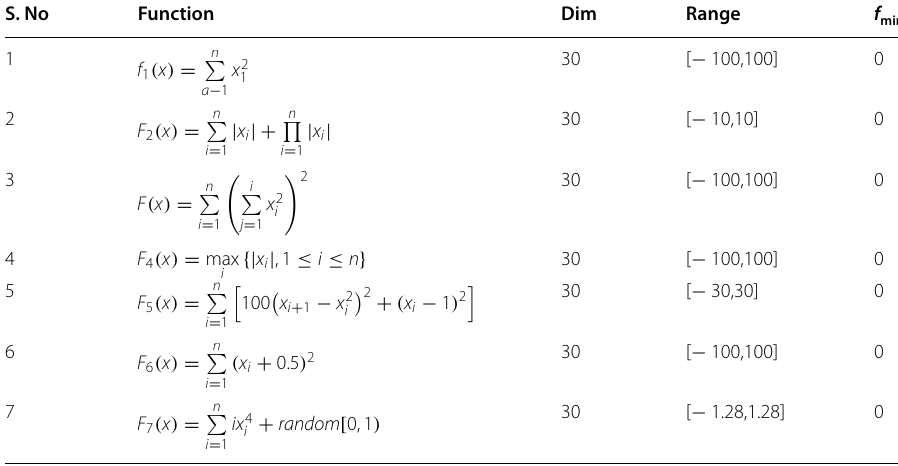
Table 1 Uni-model test